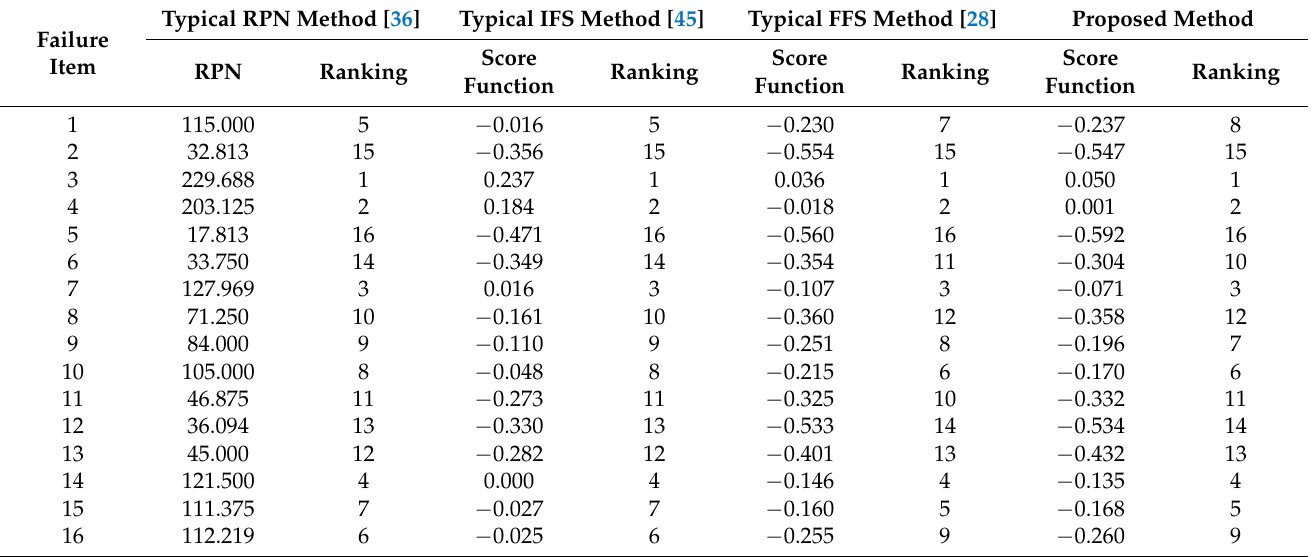
Table 11. The main difference of risk priority ranking between different calculation methods.